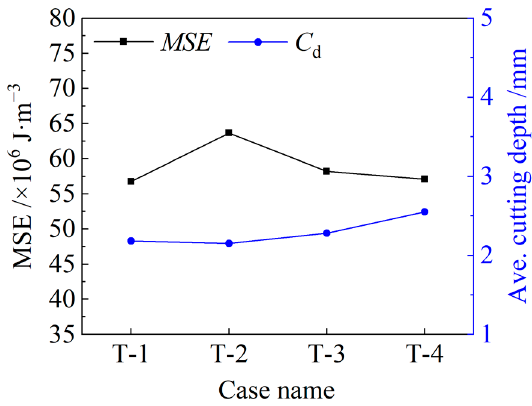
Figure 16. Statistical results of MSE and average cutting depth.